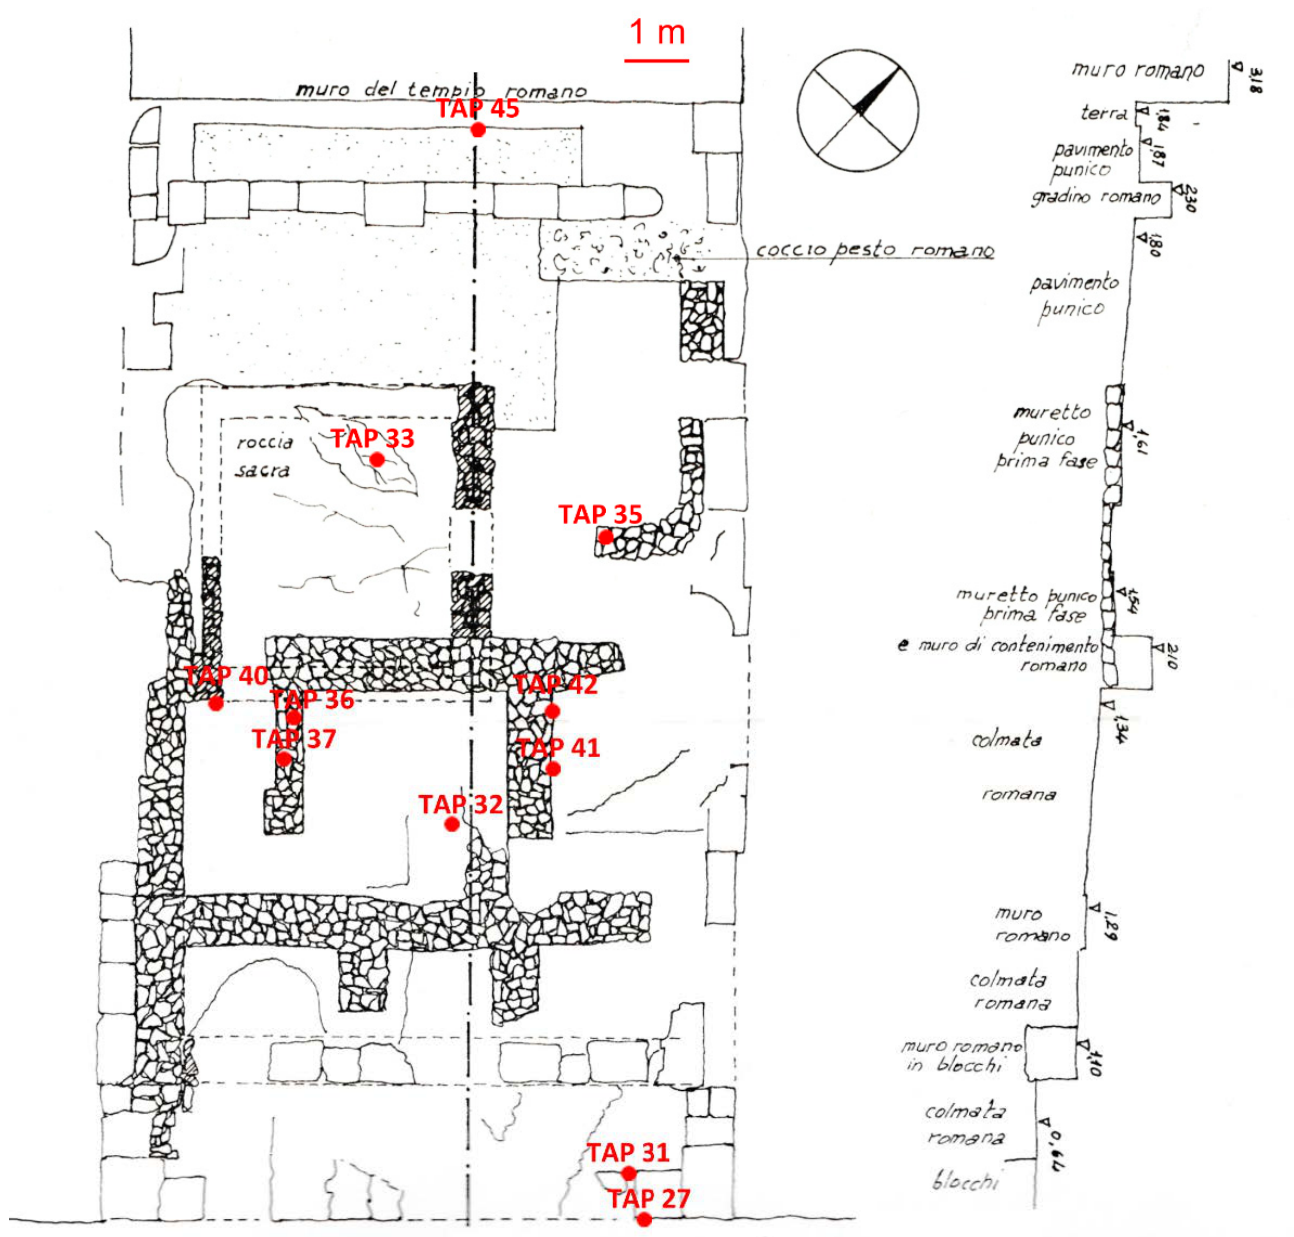
Figure 6. Sampling position on the map from the Punic Temple (from Zucca [1], modified).